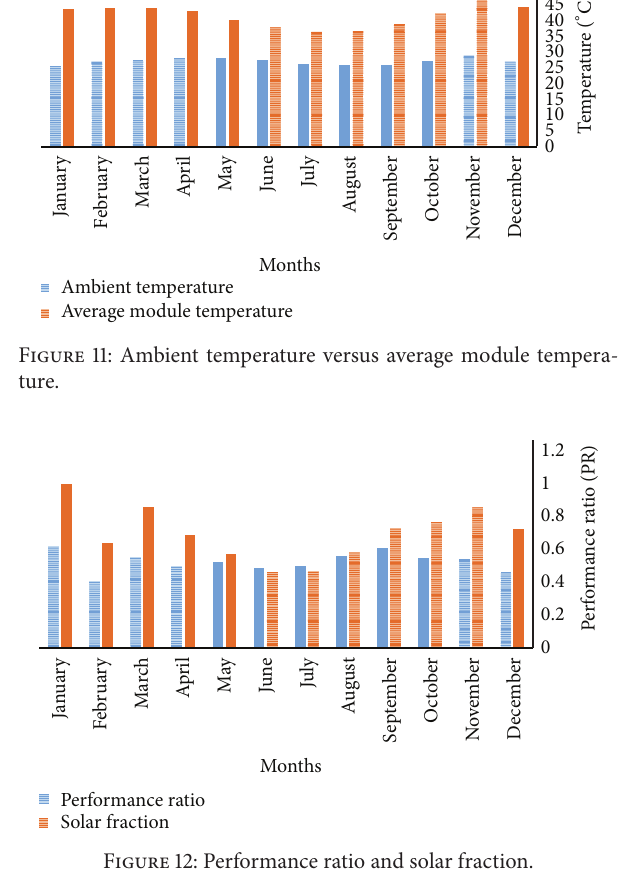
Table 4: Costs of all items [16, 17].